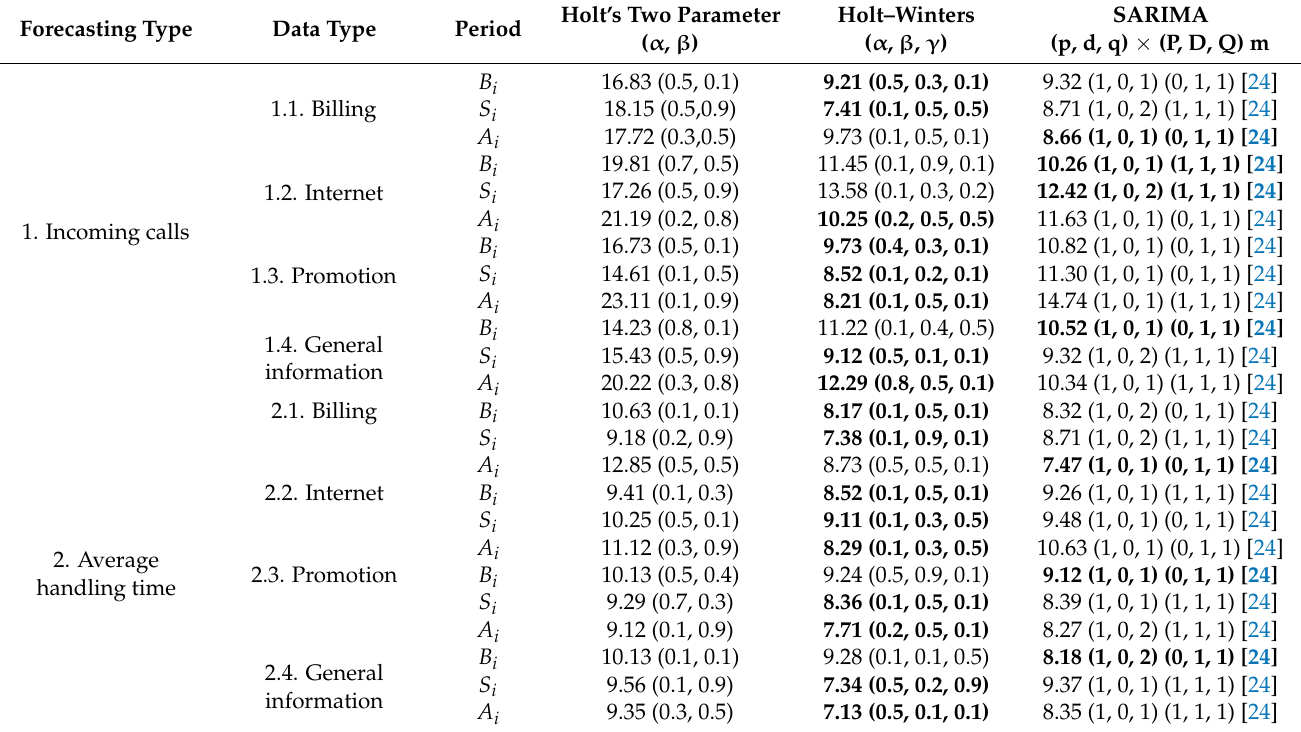
Table 6. Comparison of the MAPEs for data type 1.